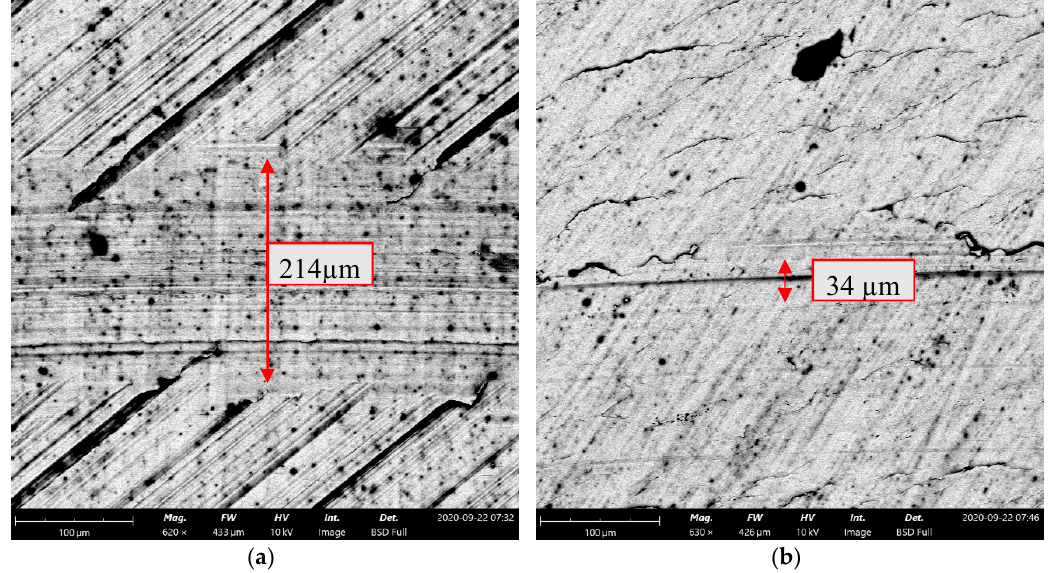
Figure 9. SEM views of the milled surface ( a ) and burnished surface with pressure of 20 MPa ( b ) after tribological tests at the normal load of 30 N.